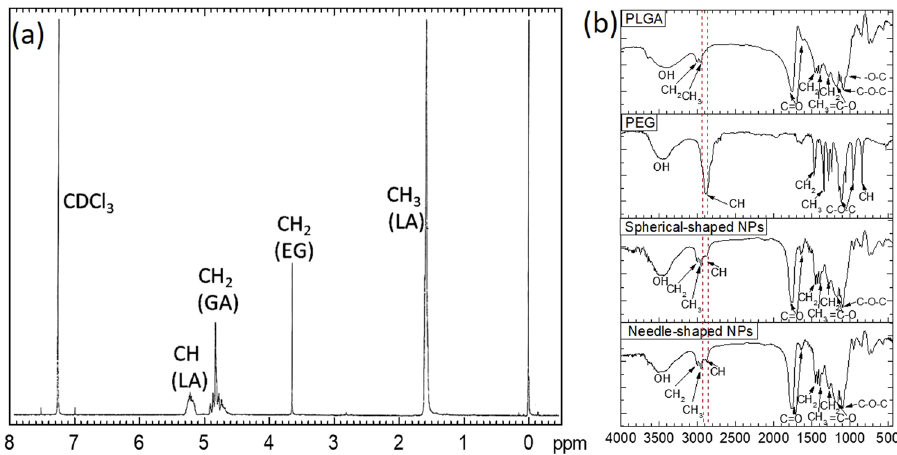
Figure 2. Chemical characterization of PLGA-PEG NPs. ( a ) 1H-NMR spectrum of PLGA-PEG copolymer showing their chemical composition, ( b ) Typical FTIR spectrum of PLGA, PEG, and PLGA-PEG NPs (both spherical and needle-shaped).